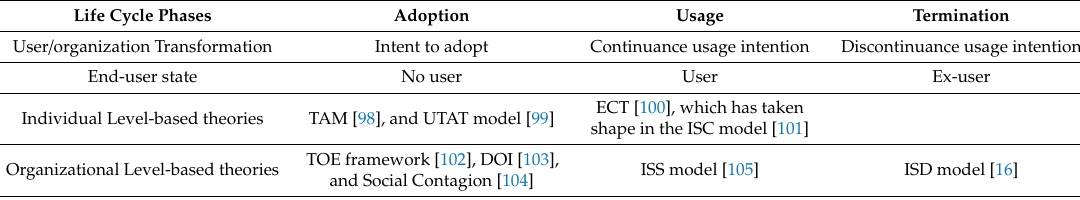
Table 2. Life Cycle of An IS with Di ff erent Theoretical